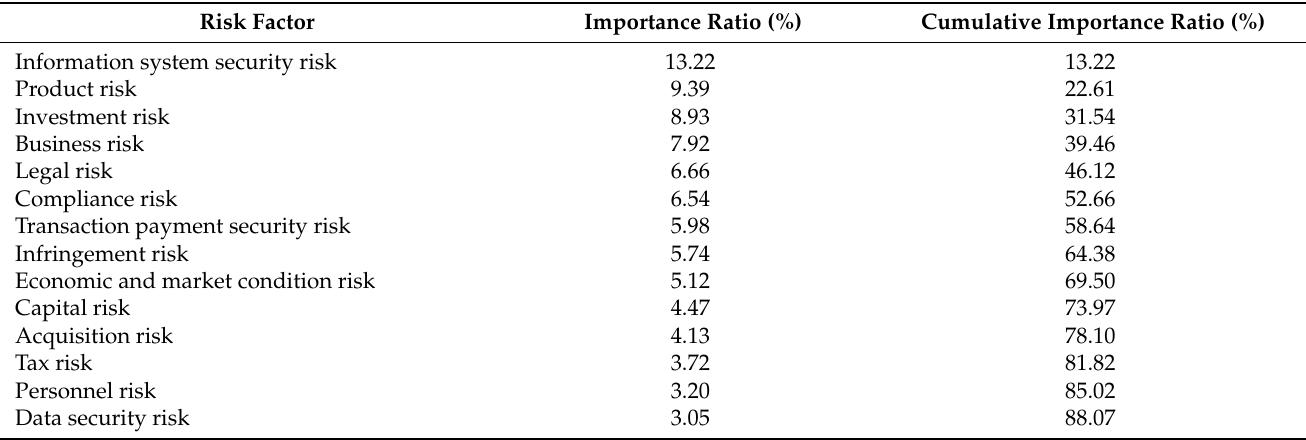
Table 2. The importance ratios of 20 fintech risk factors from 2015 to